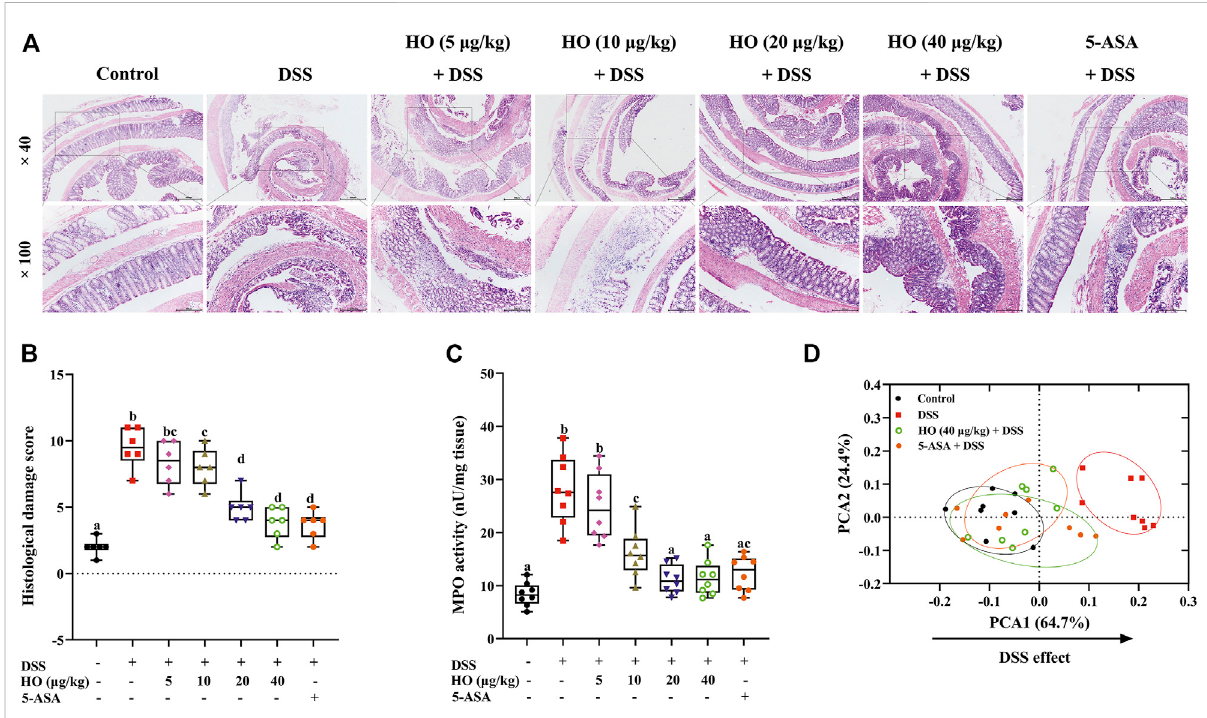
FIGURE 2 HO treatment prevents DSS-induced colitis in mice. (A) Photomicrographs of mice colonic sections stained by hematoxylin and eosin. (B) Histological damage score. (C) MPO activity. (D) PCA for colitis parameters of four different treatment groups. The data are expressed as mean ± S.E.M. ( n = 6 – 8). Bars with different letters represent signi fi cant differences between groups by Fish ’ s LSD test ( p <